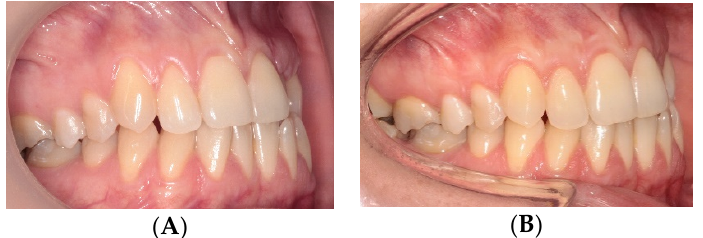
Figure 12. Test group patient: ( A ) Multiple adjacent gingival recessions at baseline ( B ) 24 months post-surgery.